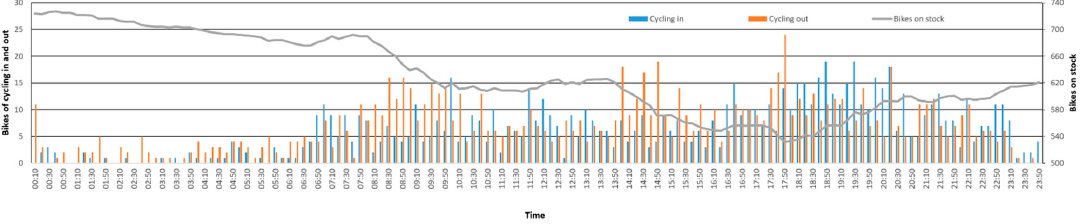
Figure 5. Cycling-in and cycling-out bikes and stock changes around the Houhai metro station every 10 minutes.